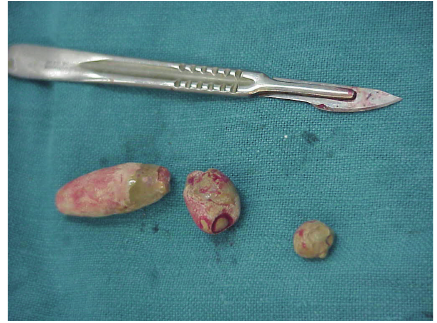
Figure 2: Stone being extracted using an artery forceps.